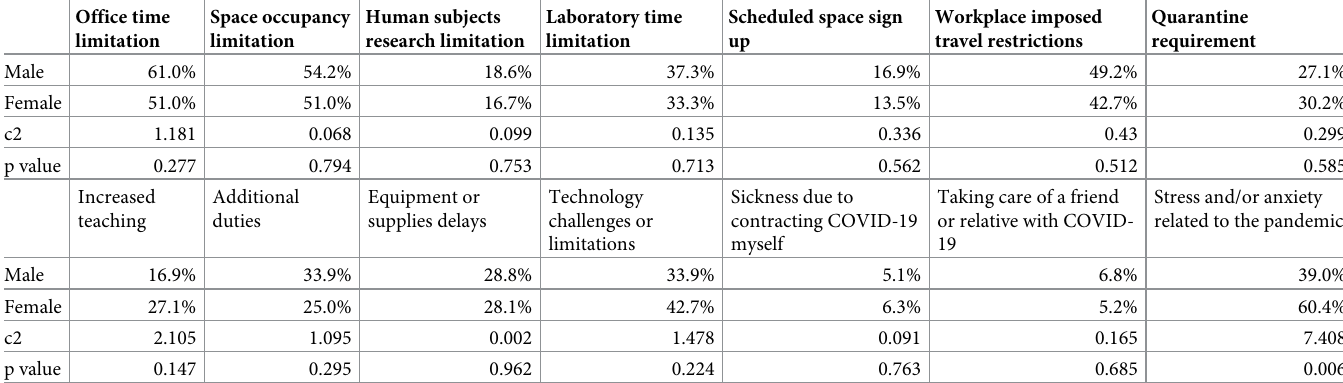
Table 3. Factors that affected productivity.